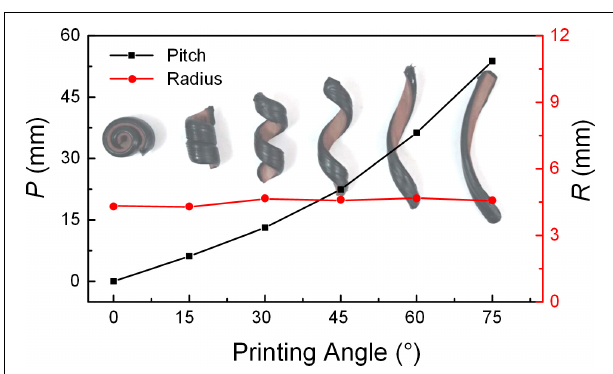
FIGURE 7 | Changes in the pitch and radius of the deformed PU-SMPVC bilayer structure in response to temperature (85 ◦ C). The insets represent corresponding deformed